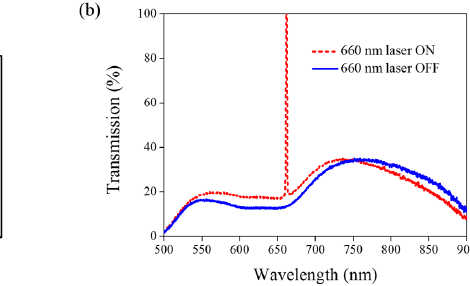
Figure 12. ( a ) POM images (picture area: 270 μ m × 320 μ m) and ( b ) transmission spectra of AQ dye-doped CLC containing A3 molecules (3 wt% AQ dye, 15 wt% A3, 20 wt% S811, and 62 wt% MDA3461) under different conditions of 660-nm wavelength laser exposure. The laser intensity was 100 mW/cm 2 .